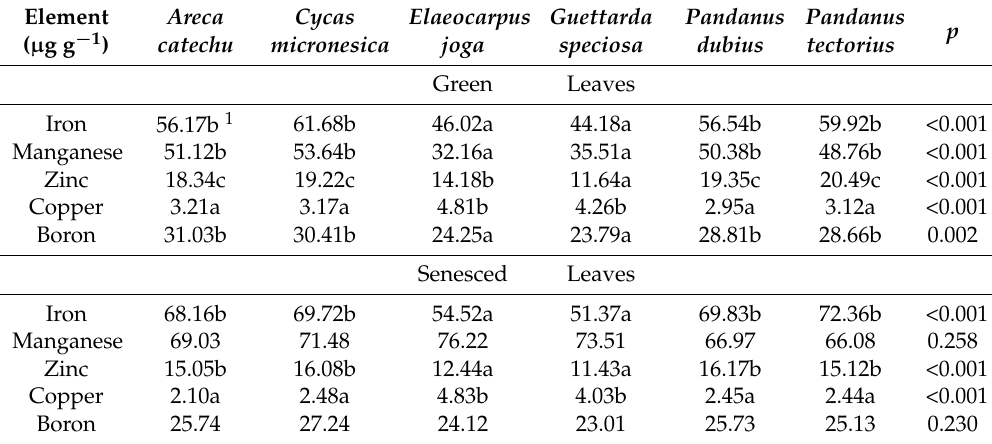
Table 2. Concentration of micronutrients in green and senesced D. guamense leaves as influenced by host tree identity ( n =